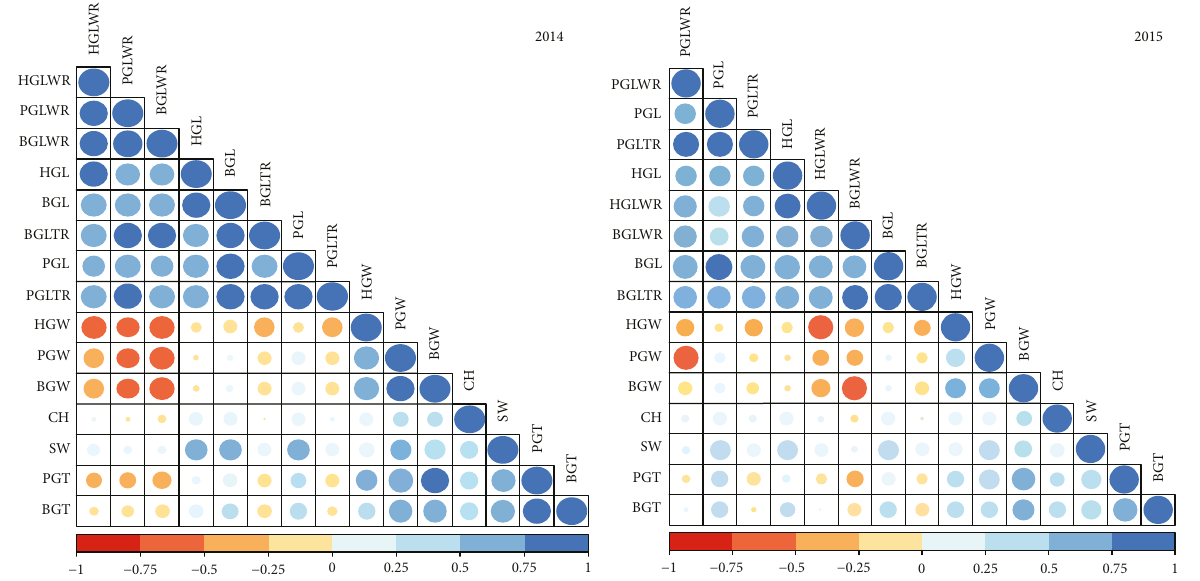
Figure 2: Correlation analysis of 15 traits of 157 RILs in 2014 and